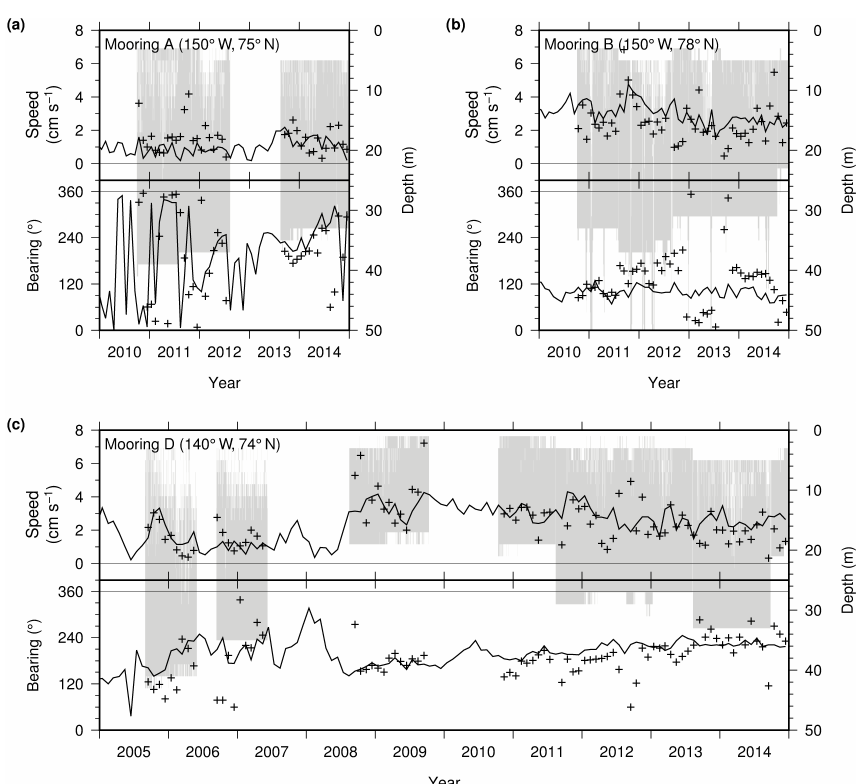
Figure 2. The satellite-derived current speed and bearing (black lines) are shown against the ADCP-derived currents (crosses) for (a) moor- ing A, (b) mooring B and (c) mooring D. The data availability is shown as a function of depth (right axes) by the grey shaded